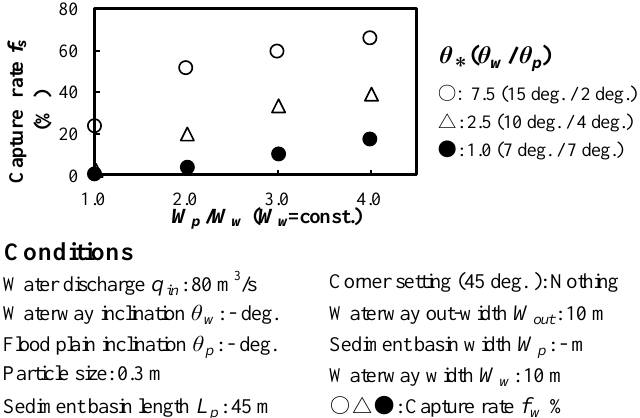
Figure 25. Effects of changes in the sediment retarding basin width and gradient on sediment capture.